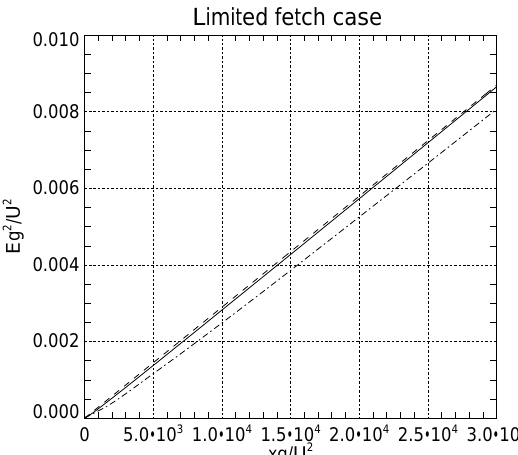
Figure 14. Dimensionless mean frequency as the function of R ωn d ω d θ the dimensionless fetch, calculated as (cid:104) f (cid:105) = 1 R n d ω d θ , where 2 π n(ω,θ) = ε(ω,θ) is the wave action spectrum, for wind speed ω 10ms − 1 (solid line) and 5ms − 1 (dashed line). The dash-dotted ) − 0 . 3 with the empir- line is the self-similar dependence 3 . 4 · ( xg U 2 ical coefficient in front of